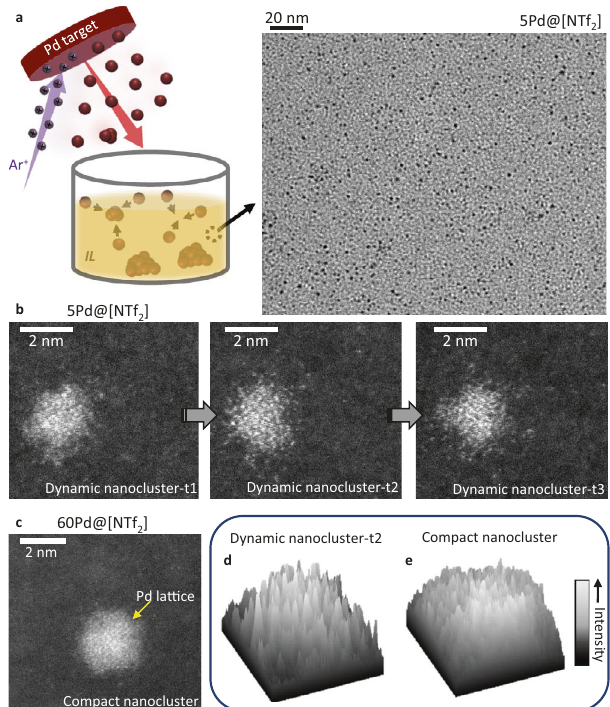
Fig. 1 The magnetron sputtering process and electron microscopy images of Pd nanoclusters in ILs. a Scheme of the Pd magnetron sputtering deposition in IL. Bright- fi eld TEM image shows the homogenous size distribution of 5Pd@[NTf 2 ]. b Aberration-corrected scanning transmission electron microscopic (AC-STEM) images acquired over time (details in Supplementary Fig. 8) to show the dynamic character of 5Pd@[NTf 2 ] system. c AC-STEM image of Pd species deposited for 60Pd@[NTf 2 ] (details in Supplementary Fig. 11) shows nanocluster with a more compact structure compared to 5Pd@[NTf 2 ], with metallic Pd lattice planes being observed. d , e Intensity histograms were taken from AC-STEM images to highlight the difference between compact and dynamic Pd nanoclusters surfaces, respectively. The intensity bar refers to STEM image contrast, which correlates with the number of Pd atoms in the